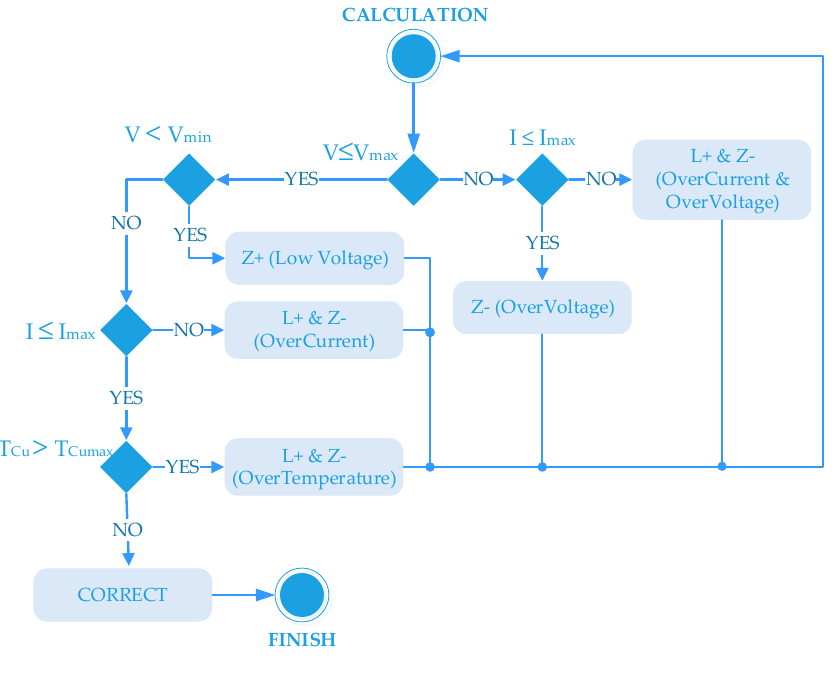
Figure 7. Automatic checking process after each